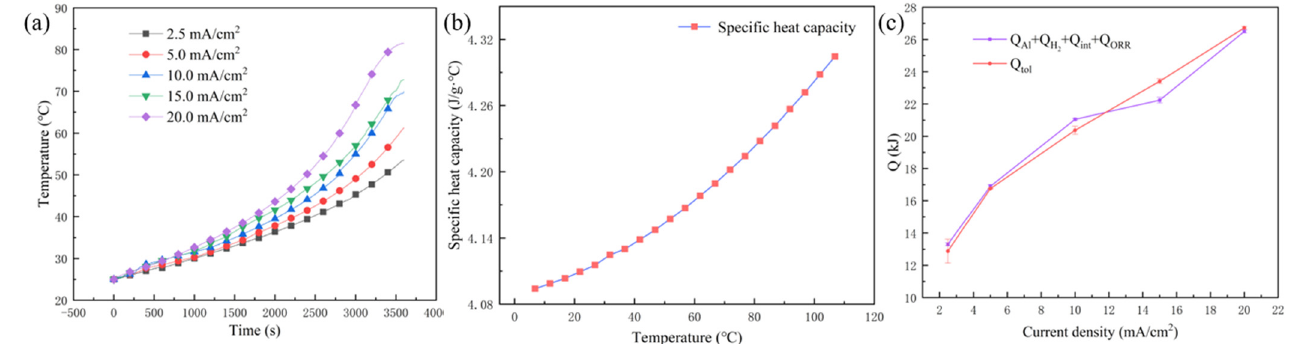
Figure 8. ( a ) The change in temperature of the aluminum–air battery with discharge time, ( b ) the specific heat capacity of the electrolyte with temperature, and ( c ) Q tol with different discharge current densities obtained by direct and indirect methods.